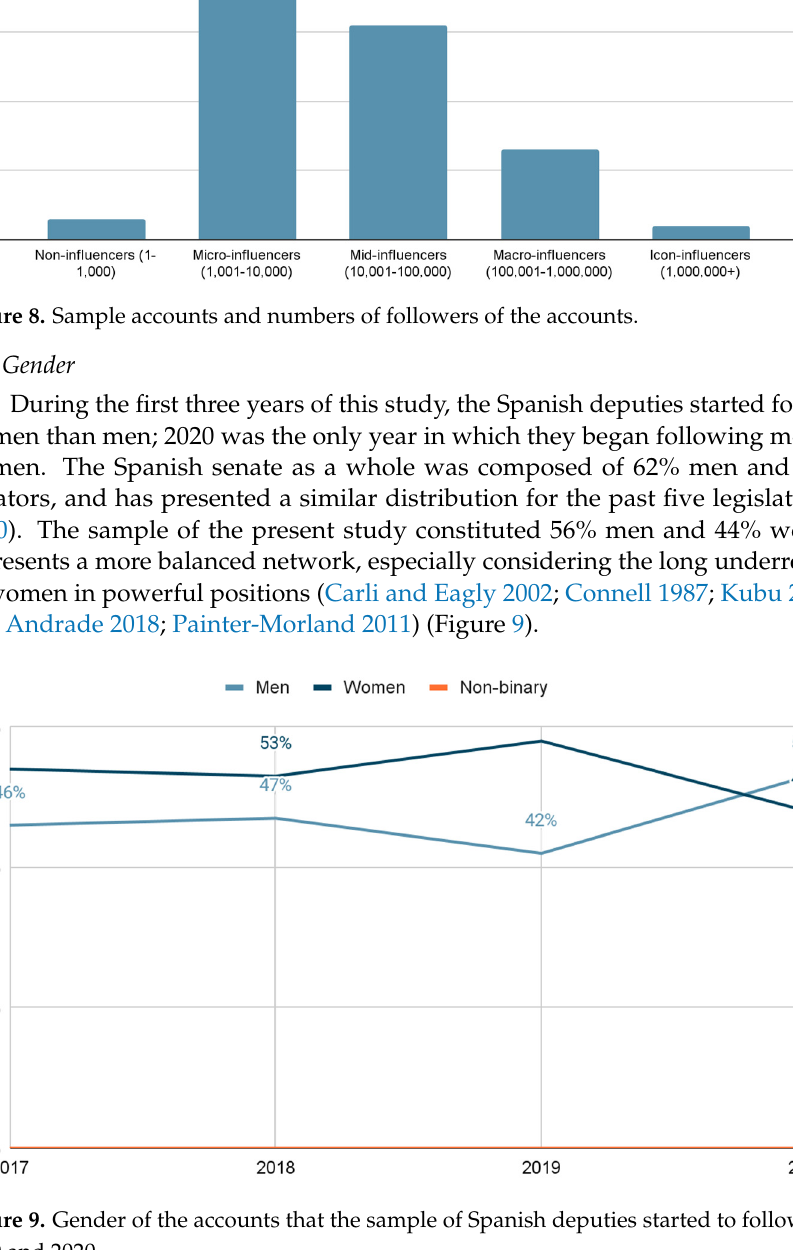
Figure 10 . Gender per category of the accounts that the sample of Spanish deputies started to follow in 2017, 2018, 2019 and 2020. 4. Discussion